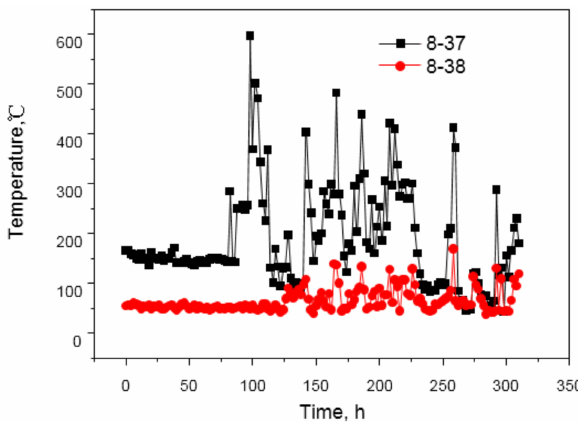
Figure 8. Changes in temperature under normal and abnormal conditions.